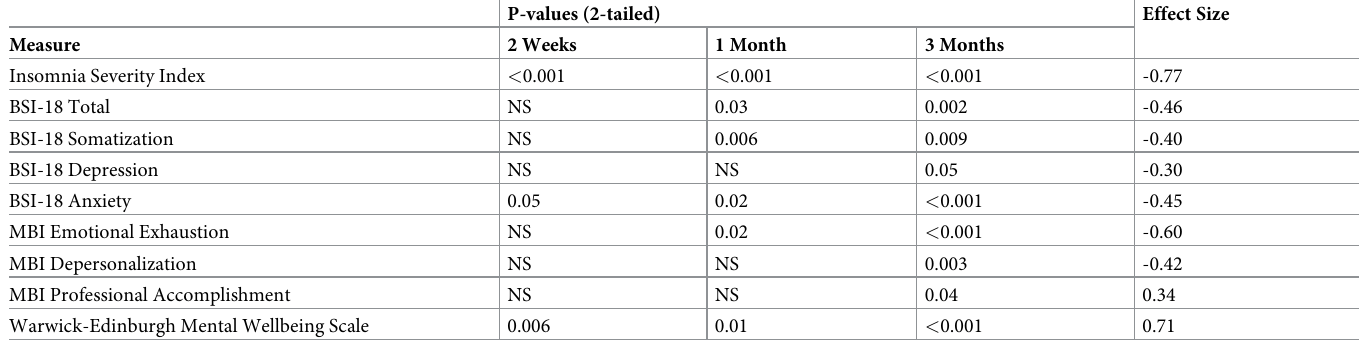
Table 5. P-values and effect sizes for between-group differences in change from baseline, based upon repeated measures ANCOVA covarying for baseline